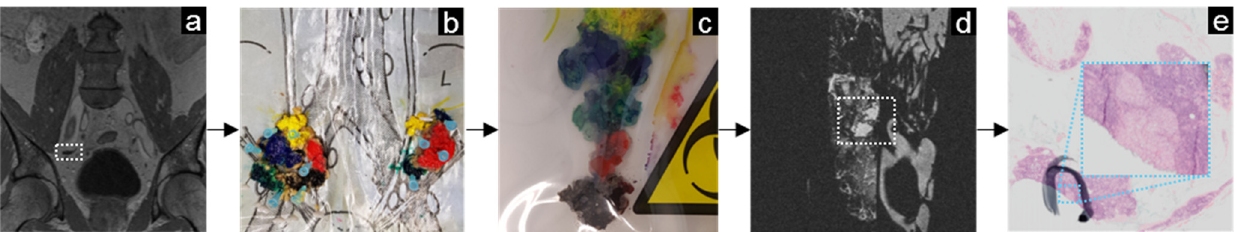
Figure 2. Example of the workflow in prostate cancer. In vivo MRI with a suspicious lymph node in the right obturator fossa (( a ) white dashed lined box). Each nodal station was colored and pinned to an anatomical reference drawing to preserve orientation ( b ). The surgical specimen was vacuum- sealed to fixate the specimen for the ex vivo MRI ( c ). Due to a short USPIO-MRI interval of 1 day, USPIO particles were still present in the resection specimen. Since there was no loss of signal intensity in this lymph node, it was regarded as suspicious (( d ) white dashed lined box). Pathology assessment with hematoxylin and eosin staining showed that this lymph node was metastatic ( e ).